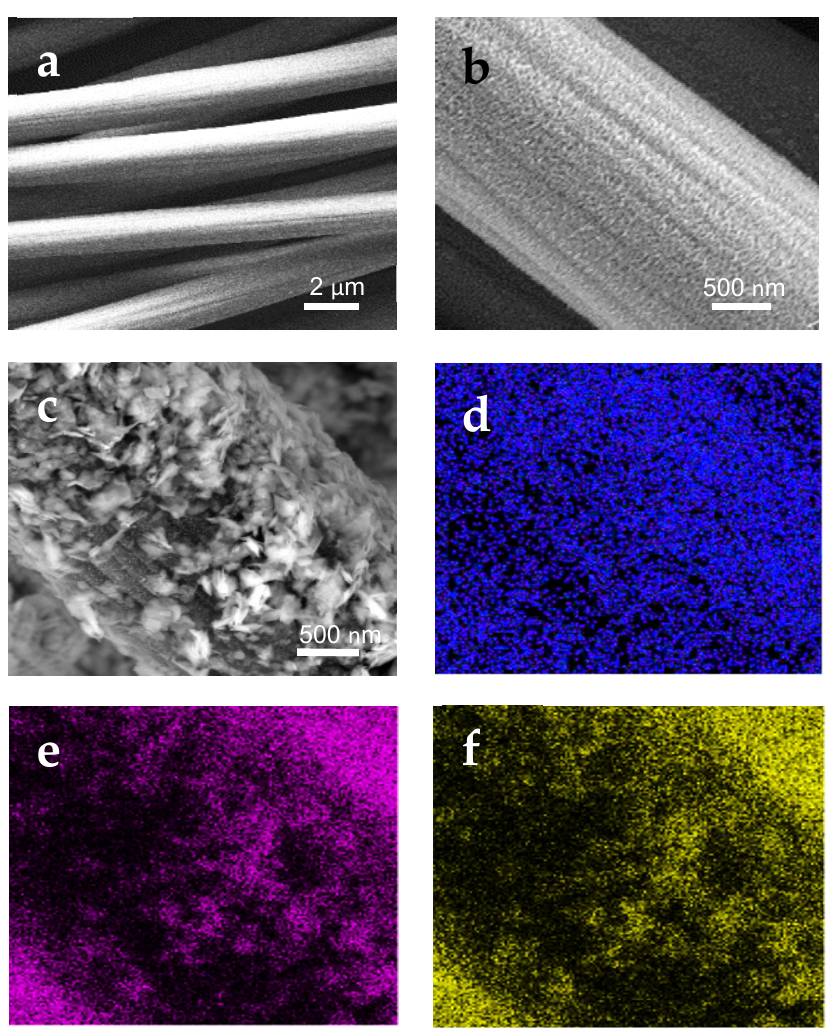
Figure 1. ( a ) Picture of the modified 2D-MoS 2 -MoO 3 -CC/screen-printed carbon electrode (SPCE); ( b ) SEM image of the 2D-MoS 2 - MoO 3 -CC network. ( c ) SEM image of the surface of a single 2D- MoS 2 -MoO 3 -CC/SPCE fiber.